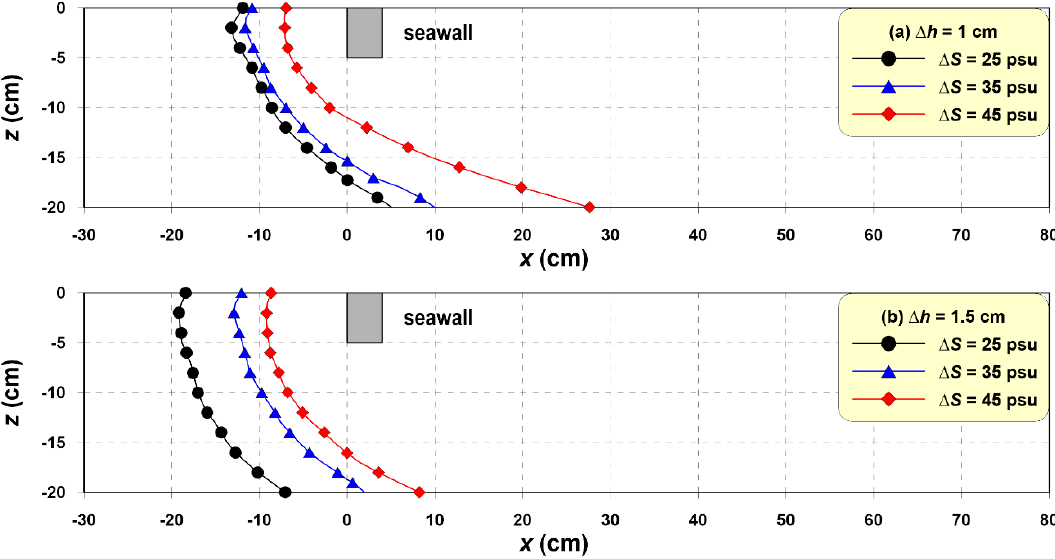
Figure 5. Spatial distributions of saltwater–freshwater interfaces according to Δ S in a coastal aquifer with a seawall for h = 10 cm at Δ h of ( a ) 1 cm and ( b ) 1.5 cm.